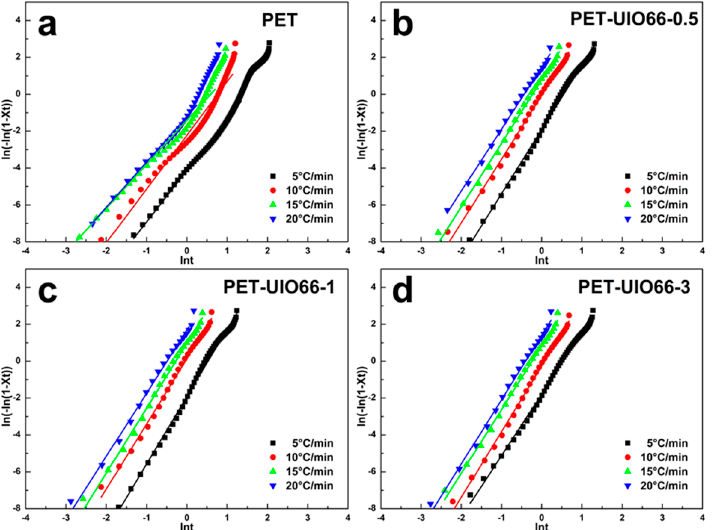
Figure 8. Non-isothermal crystallization kinetic of PET and PET/UIO-66 nanocomposites at different cooling rates: ( a ) neat PET, ( b ) PET-UIO66-0.5; ( c ) PET-UIO66-1 and ( d ) PET-UIO66-3.